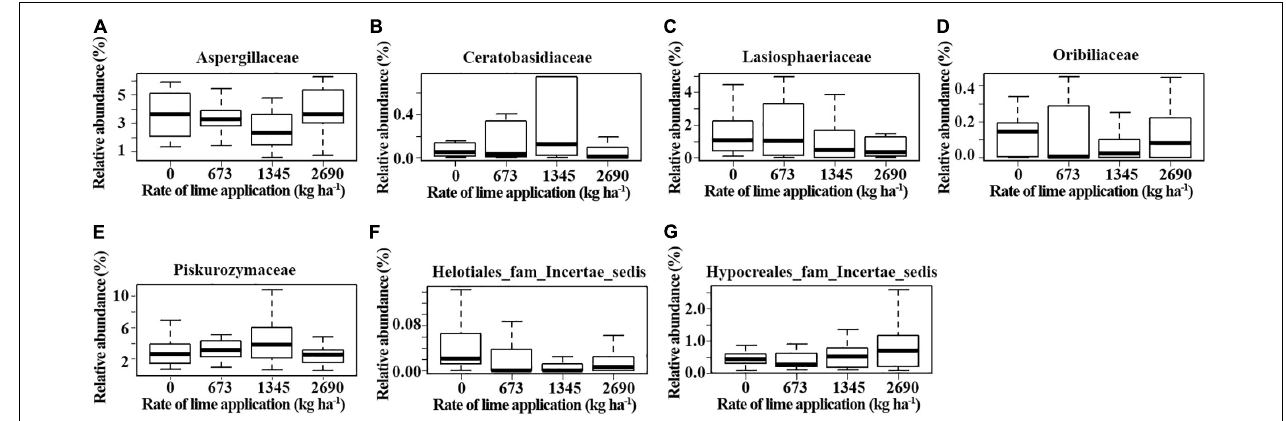
FIGURE 6 | Fungal OTUs that were differentially abundant among lime application within soil depth at each location. Soil depth: 0–7.5 cm, 7.5–15 cm, and 15–22.5 cm. Values on the X-axis represent the log2-fold difference in sequence abundance among lime amendments as estimated by DESeq2. Points to the right of red vertical line are more abundant in lime amendments, whereas those to the left of red vertical line are less abundant in lime amendments. Dots indicate OTUs, where the size of the dot is scaled by its mean abundance among all samples (baseMean > 50) and its color represents the phylum to which that OTU belongs. The nearest taxonomy assignment is presented at left. Only OTUs with a mean abundance > 10 and normalized counts > 5 and present in at least 3 samples are presented.